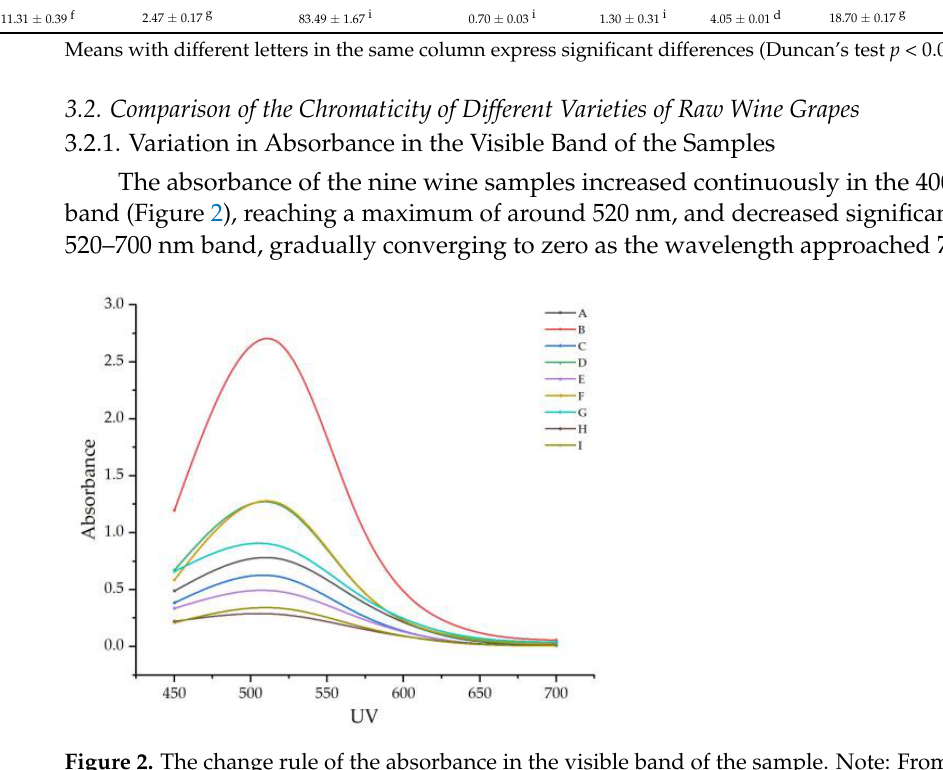
Figure 2. The change rule of the absorbance in the visible band of the sample. Note: From A to I are ‘Hassan’, ‘Zuoshaner’, ‘Beibinghong’, ‘Zuoyouhong’, ‘Beta’, ‘Shuanghong’, ‘Zijingganlu’, ‘Cabernet Sauvignon’, and ‘Syrah’.